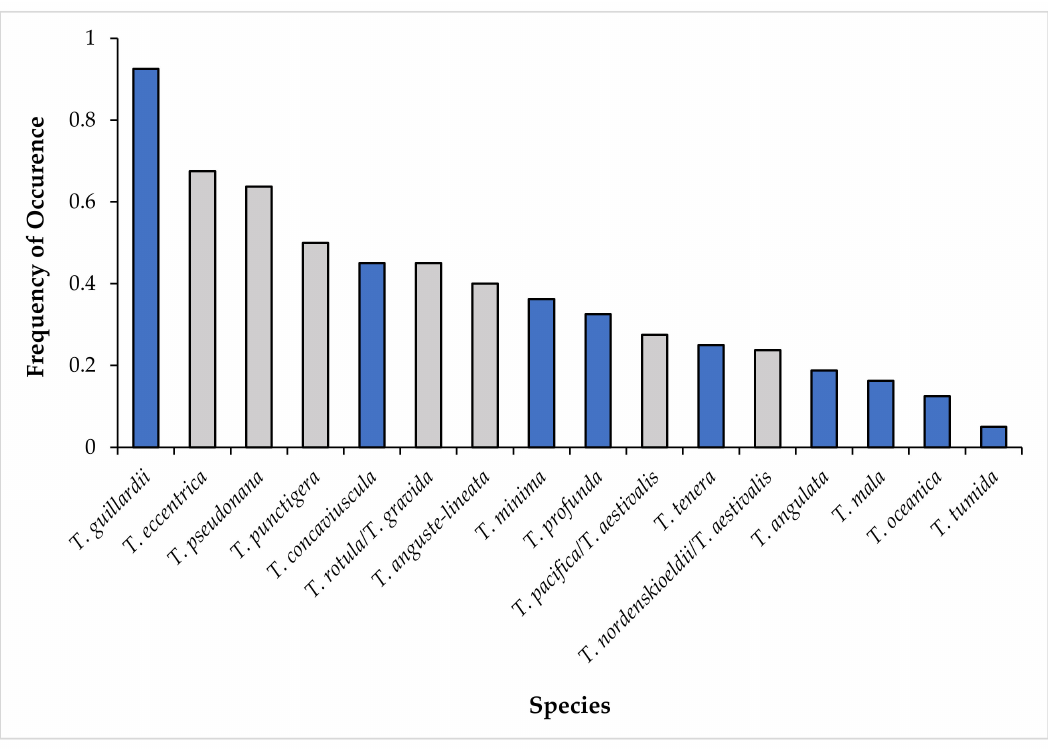
Figure 4. The frequency of occurrence of each species across all 80 sequenced field samples. Blue bars indicate newly identified species in Narragansett